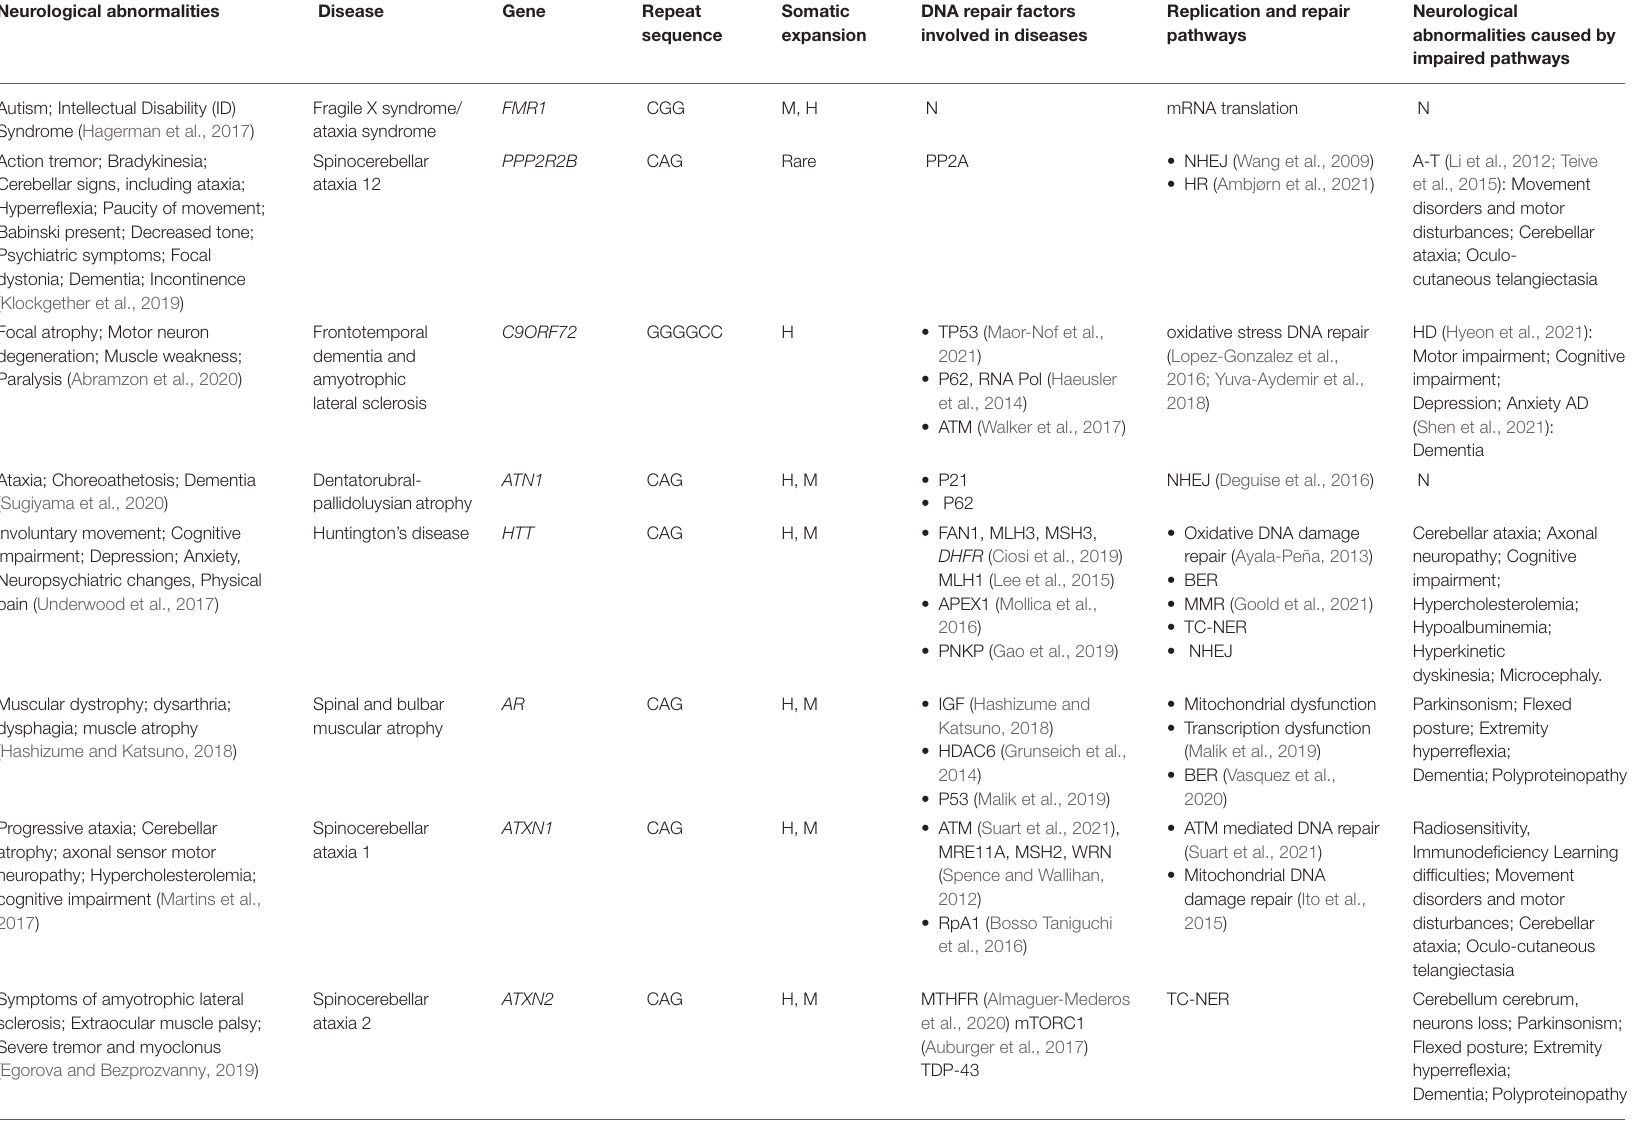
TABLE 2 | Characteristics of selected disease-causing repeat